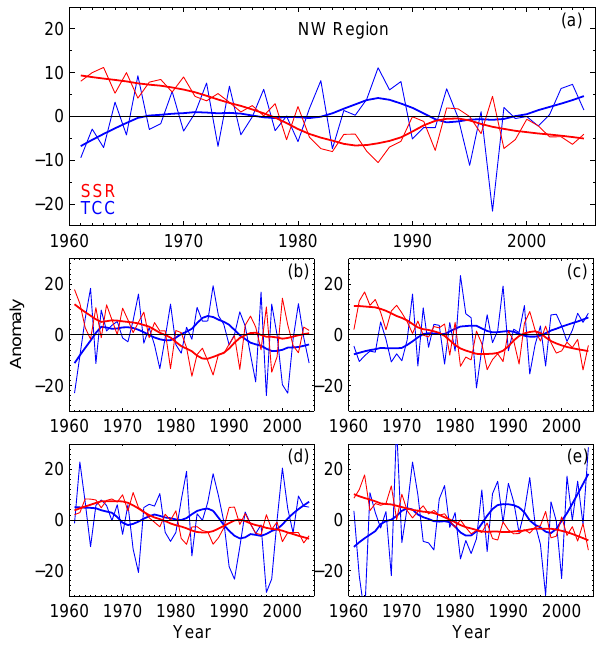
Fig. 2. Time series plots of annual anomalies of surface so- lar radiation (SSR), total cloud cover (TCC), and low cloud cover (LCC), plotted together with the smoothed series using ro- bust locally weighted regression algorithm “Lowess” in Northwest China: (a) ; spring (b) ; summer (c) ; autumn (d) ; winter (e) .